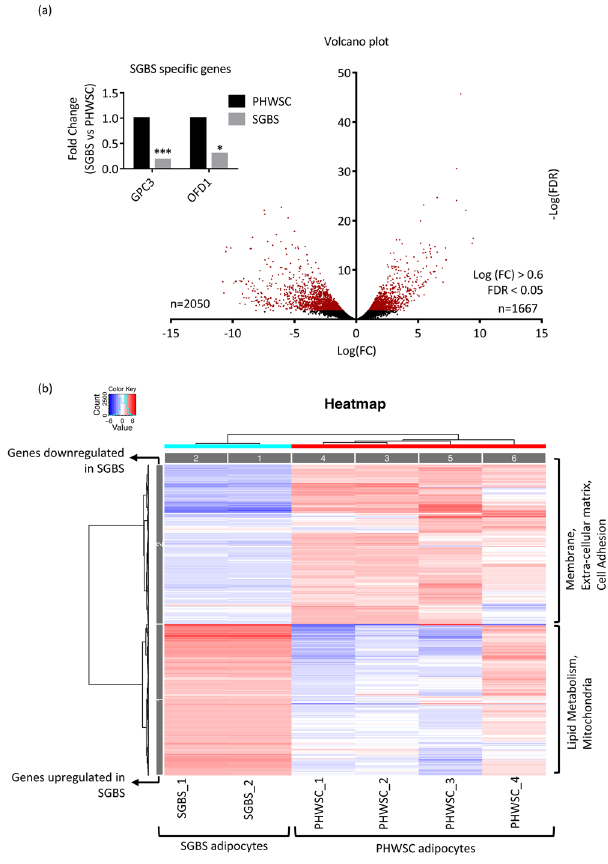
Figure 1. Global transcriptome profiling of SGBS and PHWSC adipocytes ( a ) Volcano plots displaying a number of differentially expressed genes in SGBS adipocytes compared to PHWSC adipocytes. Red dots denote statistically significant genes. Genes with FDR < 0.05 and log (FC) > 0.60 were included. ( b ) Heat map clustering top 1000 significantly upregulated (red) or downregulated (blue) genes between SGBS and PHWSC adipocytes. For PHWSC adipocytes in RNA-Seq, experiments were performed in cells derived from 4 different donors (SC_1 to SC_4, n = 4). For SGBS adipocytes, experiments were performed in duplicates (SGBS_1 and SGBS_2) from the same SGBS